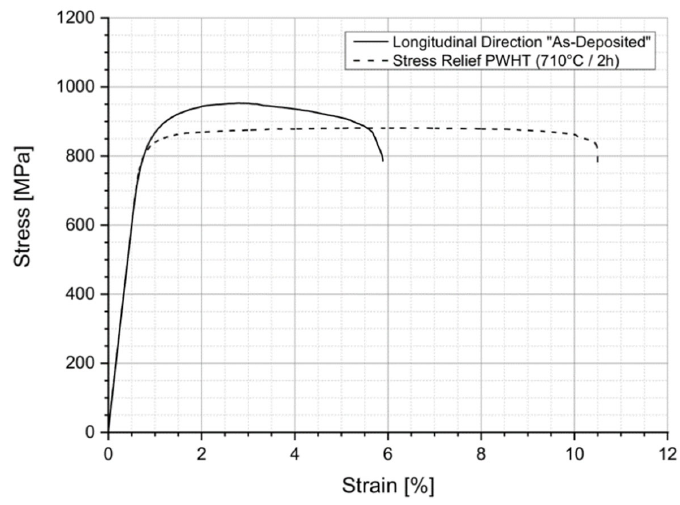
Figure 3. Microstructure of the additive Ti-6Al-4V printed with ( a ) low and ( b ) high heat dissipation intensity (adapted from [45]).